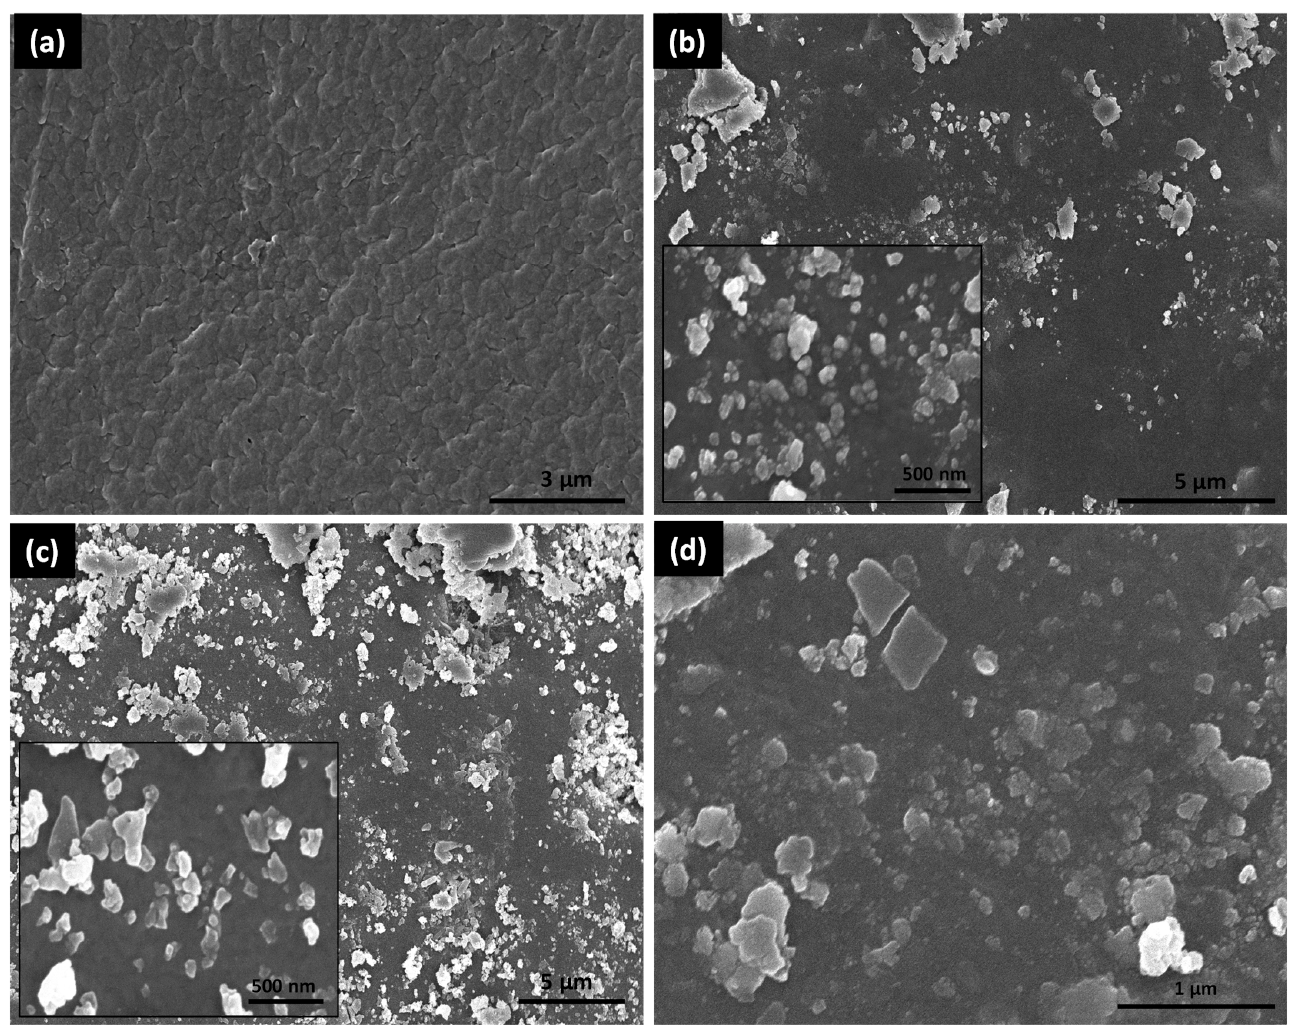
Figure 3. SEM images of ( a ) TPU ( b ) c-GO 1, ( c ) c-GO 3, and ( d ) c-GO 4.